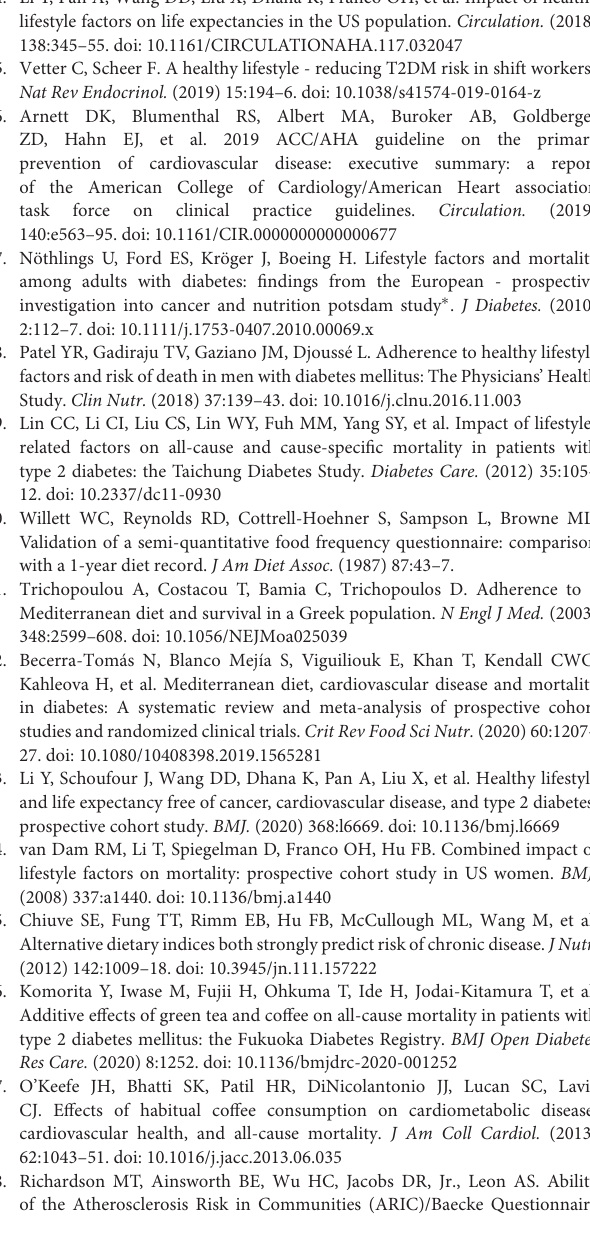
Supplementary Figure 1 | The association between healthy lifestyle score (HLS) and cardiovascular mortality in subgroup of age, sex, and race. The detailed description is the same as Figure 1 . Supplementary Figure 2 | The association between healthy lifestyle score (HLS) and cardiovascular events in subgroup of age, sex, and race. The detailed description is the same as Figure 2